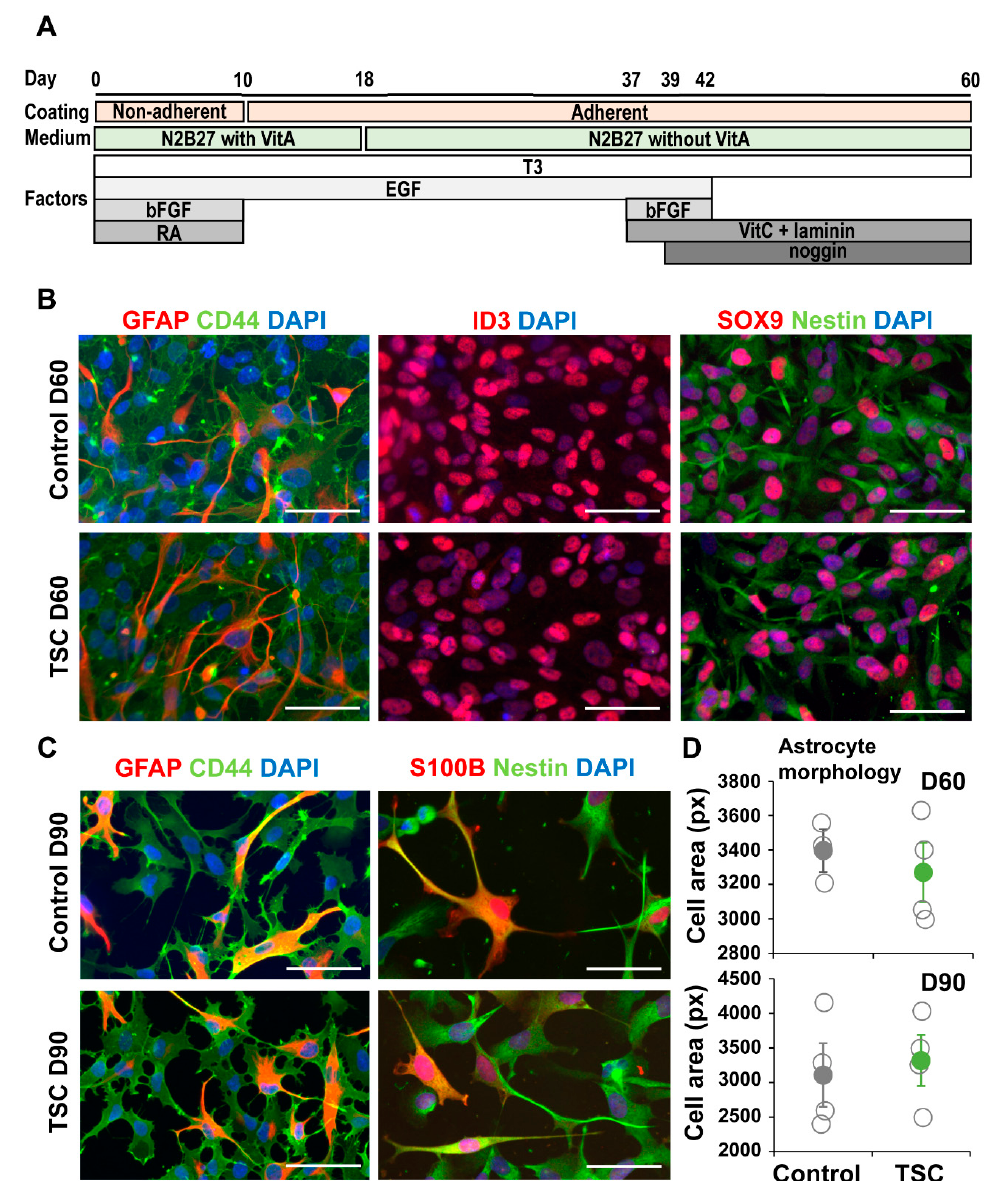
Figure 1. Tuberous sclerosis complex (TSC) iPSCs show normal astrocyte differentiation. ( A ) Schematic overview of the differentiation protocol from iPSC to astrocytes. ( B ) At day 60 of differentiation, cells present with astrocyte morphologies and express many astrocyte-associated markers. Shown are representative stainings of control and TSC astrocytes for astrocytic markers GFAP, CD44, ID3, SOX9 and Nestin. ( C ) Day-90 astrocytes are positive for astrocytic markers like GFAP, CD44, S100B and Nestin. ( D ) Morphological analysis of CD44 staining showed no change in cell size between TSC and control astrocytes at day 60 and day 90. ( B , C ) Scalebar = 50 μ m. ( D ) Data points represent average cell size per iPSC line, with solid data points representing the mean per condition ± SEM. Statistical test: independent samples t -test.